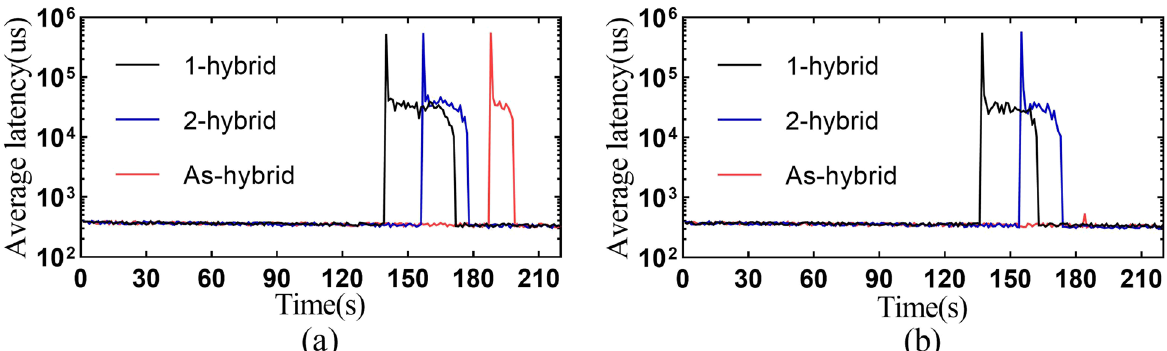
Fig. 8 Memcached service performance. a with increasing load. b with occasional load fluctuations